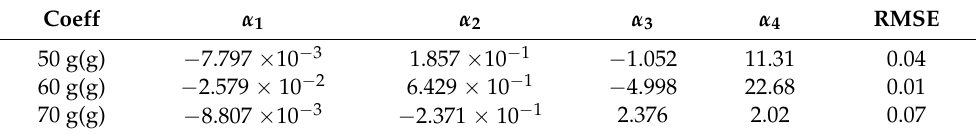
Table 1. Coefficient fitting values.